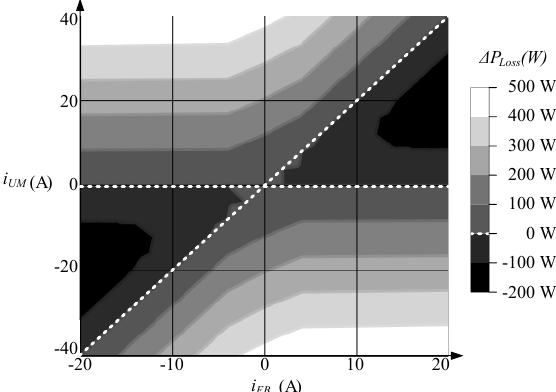
Figure 10. Difference between the losses in DPC and SPC configurations, as a function of the UM and EB currents. The darker areas correspond to SPC scheme operating with fewer losses than the original DPC scheme. For reference, it must be noted that P Loss equals to zero if i UM = 0 (i.e., horizontal axis).